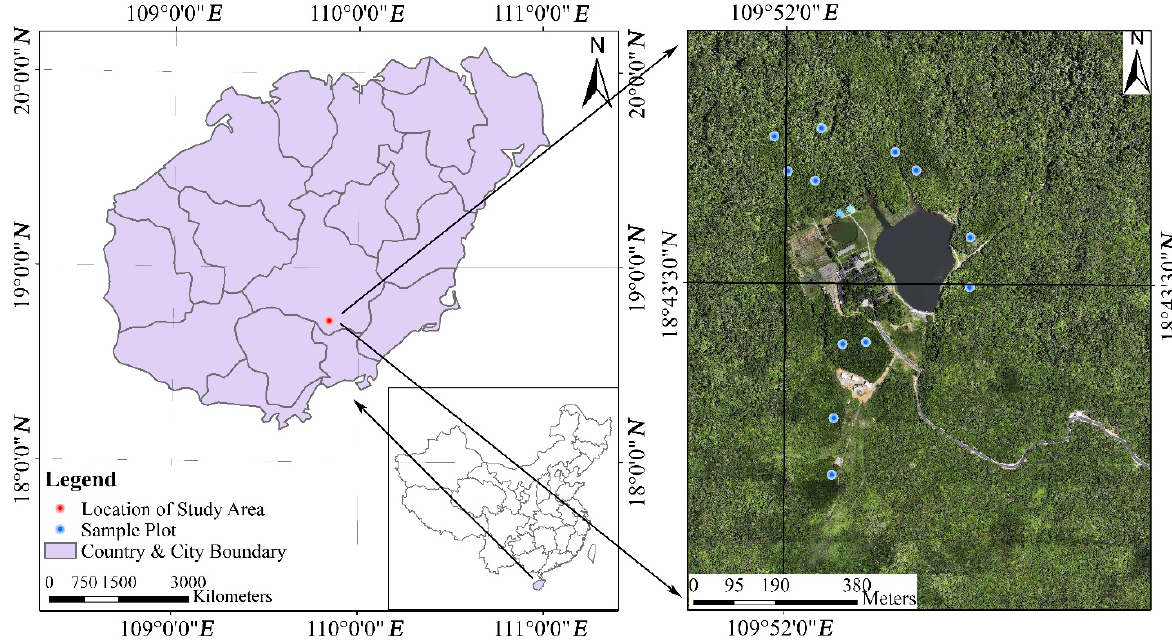
Figure 1. Distribution of the study sites in Hainan Province.